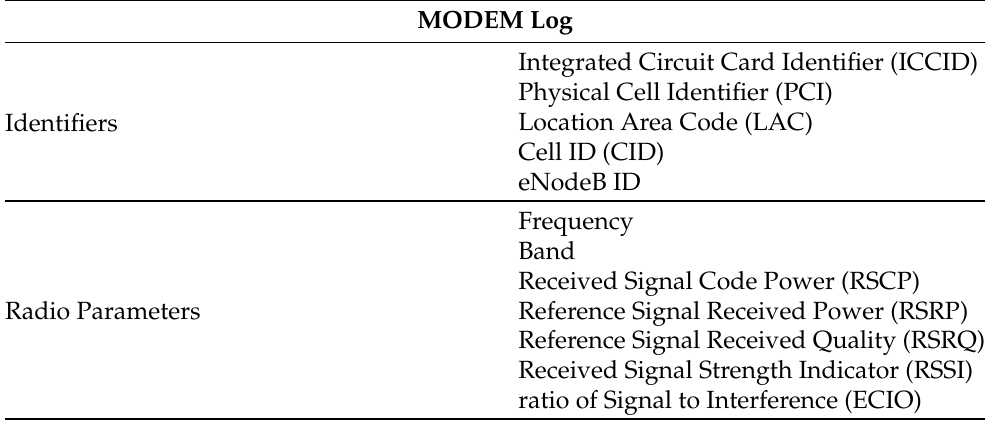
Table 2. MODEM log